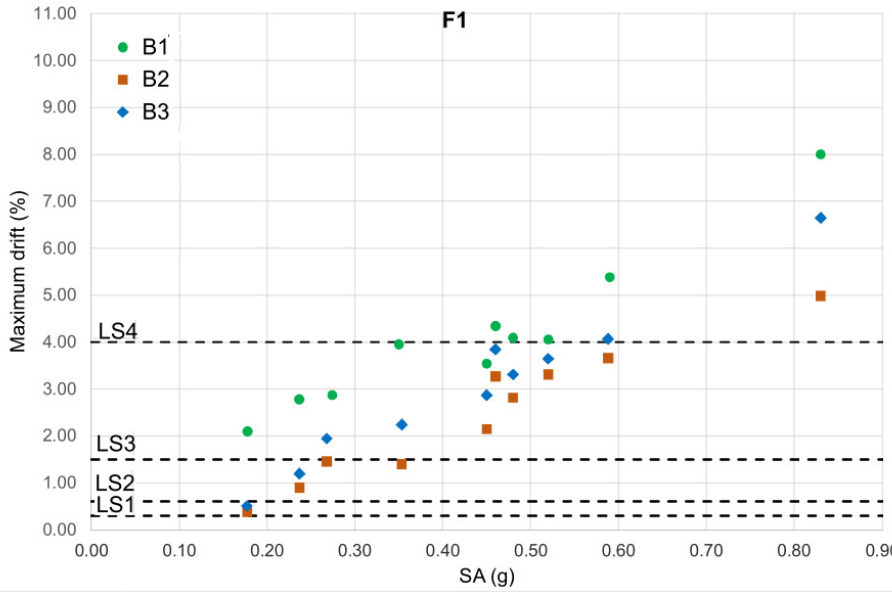
Figure 5. Results: model B1, B2, B3 considering soil F1.